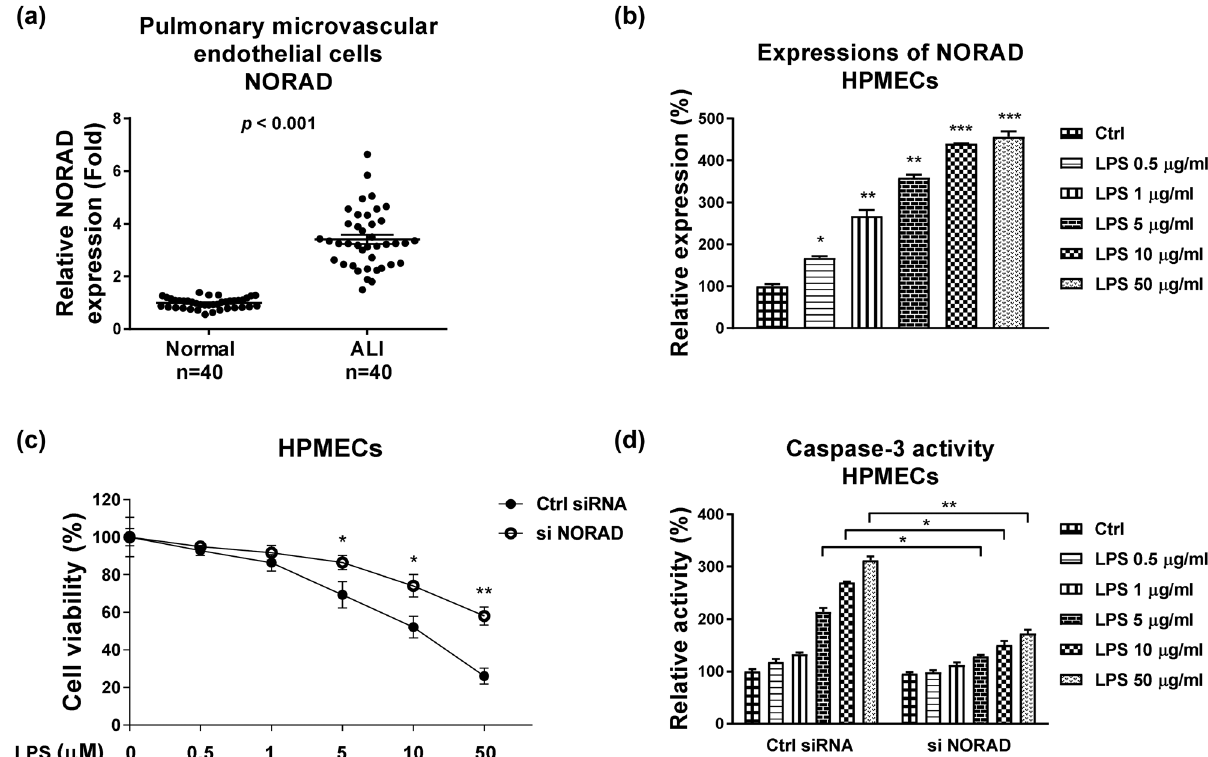
Figure 1: Roles of NORAD in the LPS - induced HPMEC cell injury. ( a ) Primary HPMECs from patient lung tissues ( n = 40 ) and healthy controls were isolated and the expressions of NORAD were analyzed by qRT - PCR. ( b ) HPMECs were treated with LPS at 0, 0.5, 1, 5, 10, or 50 µg/mL. Expressions of NORAD were examined by qRT - PCR. ( c ) HPMECs were transfected with control siRNA or si NORAD, followed by treatment with LPS at the indicated concentrations. Cell responses were evaluated by MTT assay and ( d ) Caspase - 3 activity assay. *, p < 0.05; **, p < 0.01; ***, p <